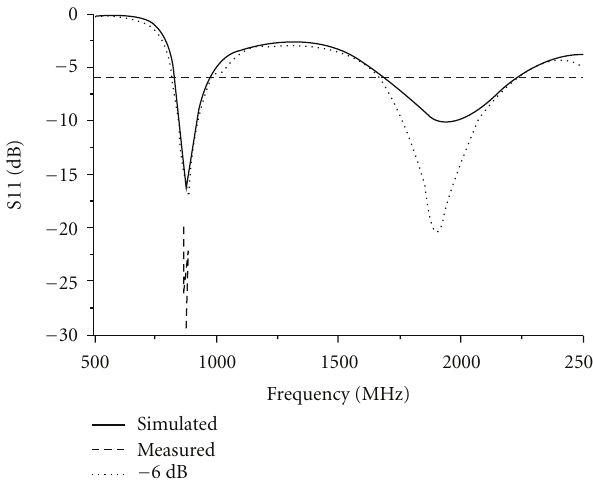
Figure 3: Measured and simulated S11 for the proposed antenna.